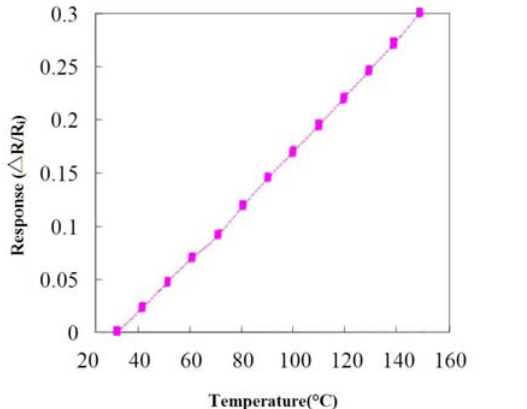
Figure 8. Calibration curve of the micro temperature